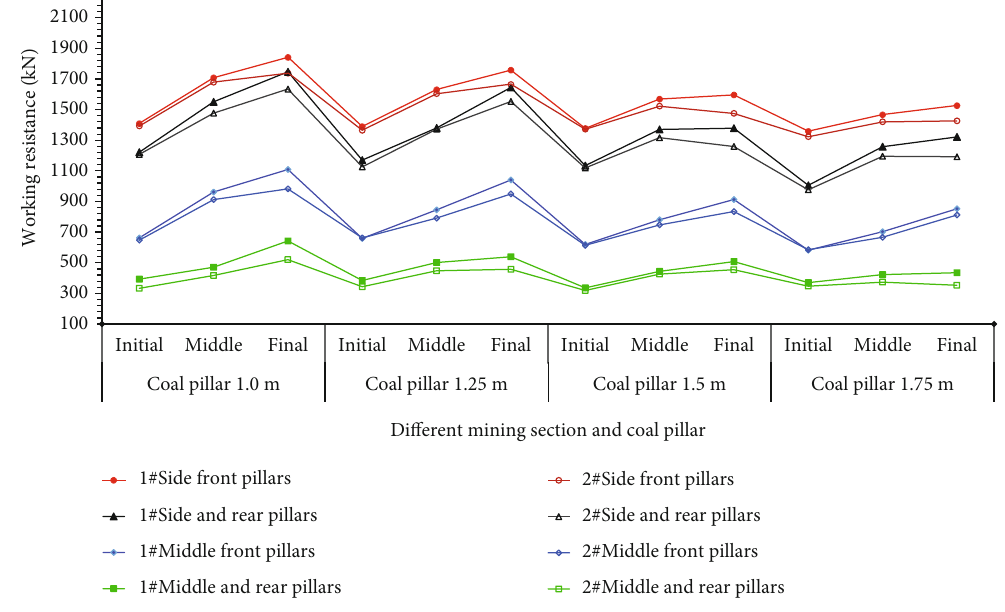
Figure 6: Simulated relationship between coal pillar widths and pillar pressures in di ff erent mining stages.